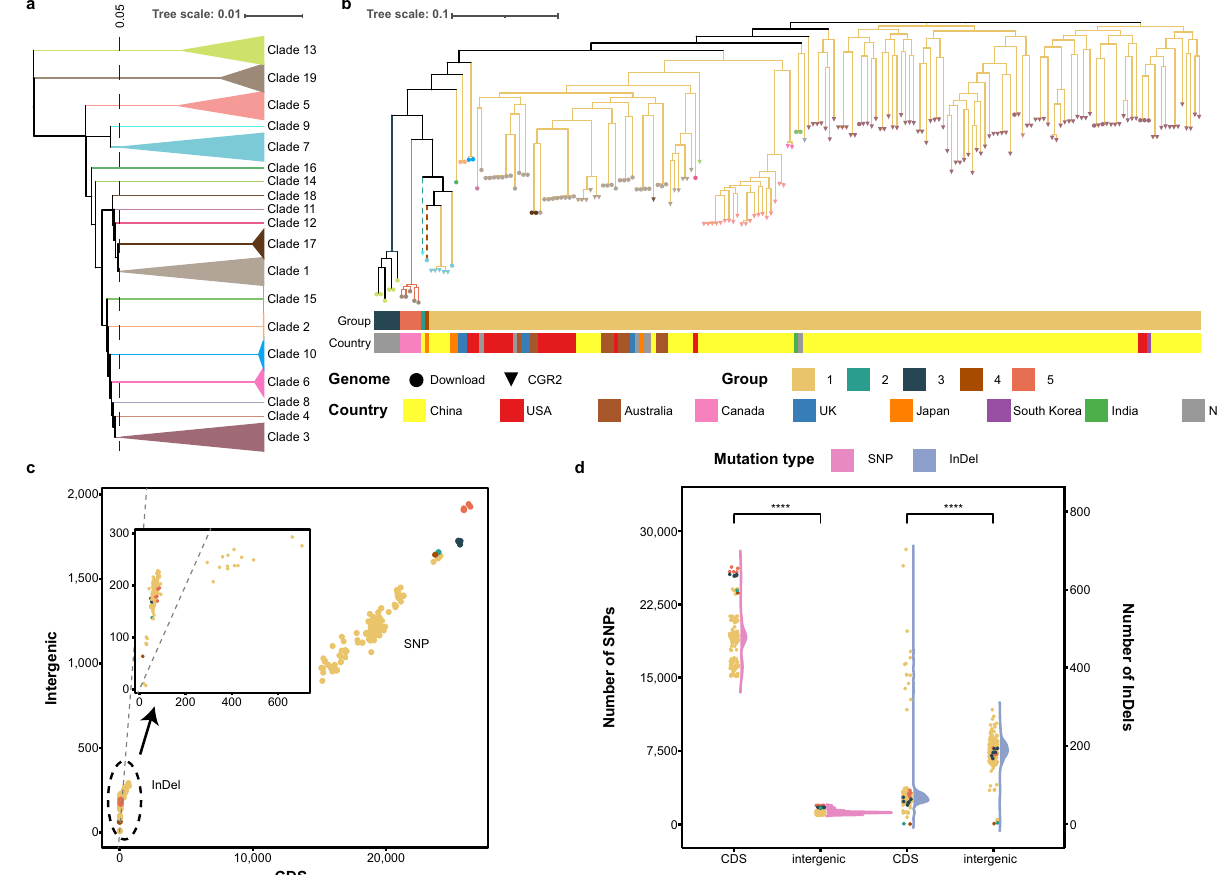
Fig. 5 | Genome-wide analysis of 197 Collinsella aerofaciens genomes. a Whole- genome phylogenetictree constructedbased onANI. According to thedistanceof 0.05, the genome can be divided into 19 clades. b Consistency between the genomicSNPphylogenetictreeandthe5groupsofCDSsequences.Tipshapesand colors represent the genome source and ANI clade, respectively. Dashed lines indicate the singletons in group 2 and group 4. For each genome, the fi rst layer